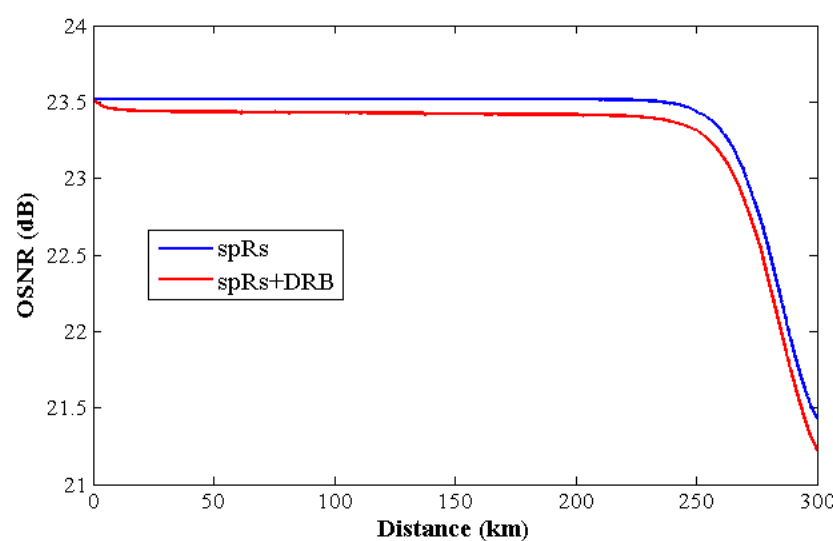
Figure 7. OSNR vs. distance, with only spontaneous Raman scattering (spRs) and with both spRs and DRB.